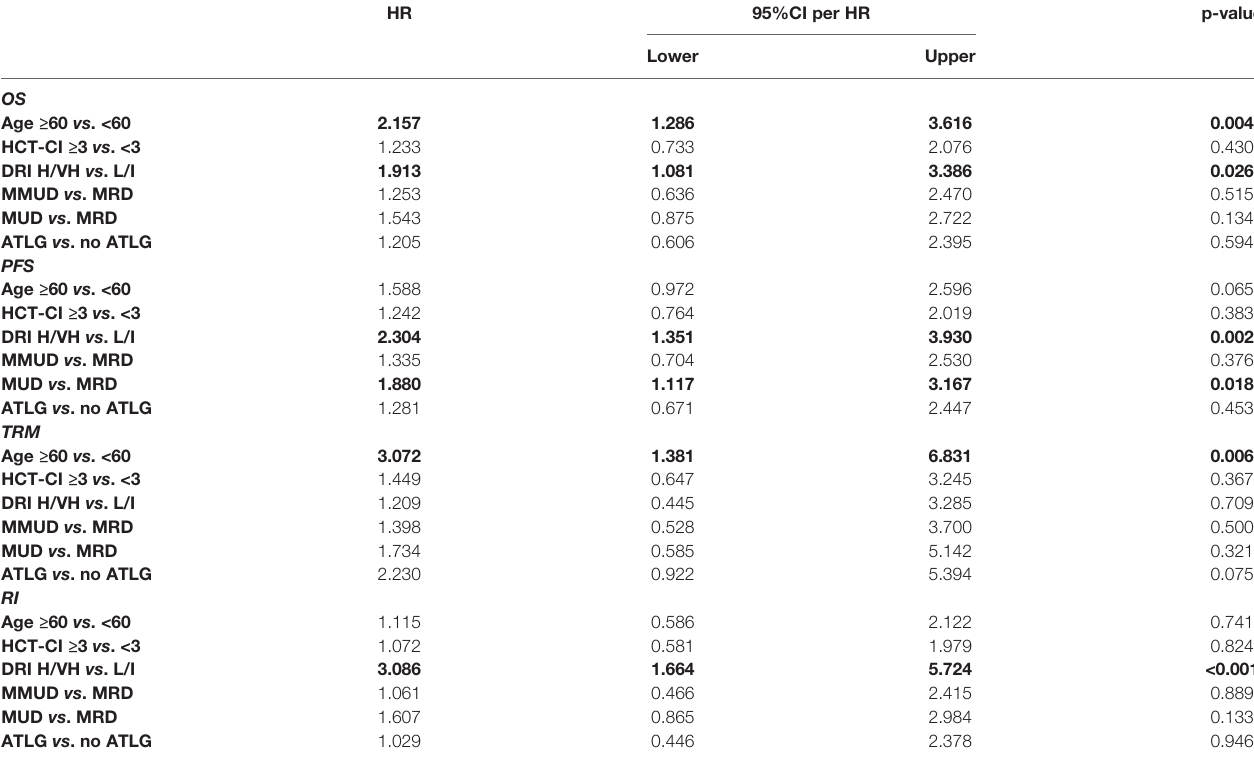
HR 95%CI per HR p-value Lower Upper